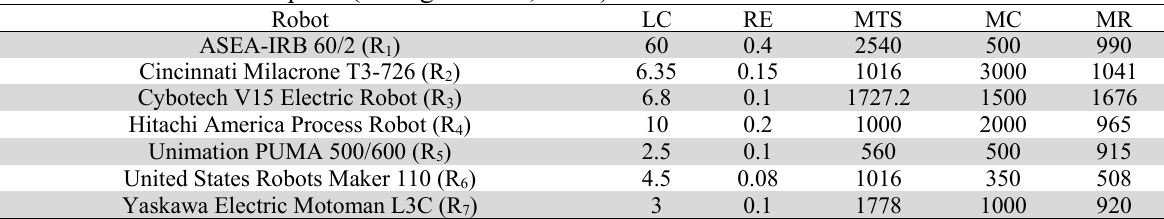
Decision matrix for Example 1 (Bhangale et al., 2004)